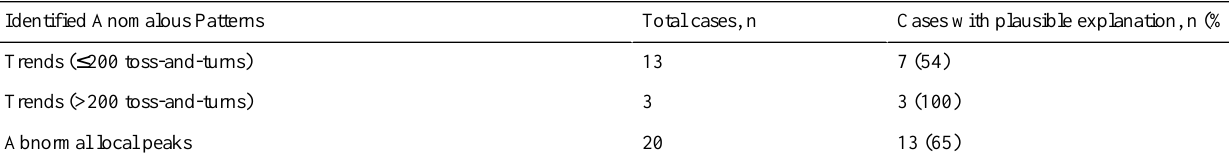
Table 4. Summary of qualitative analysis of abnormal toss-and-turn patterns.